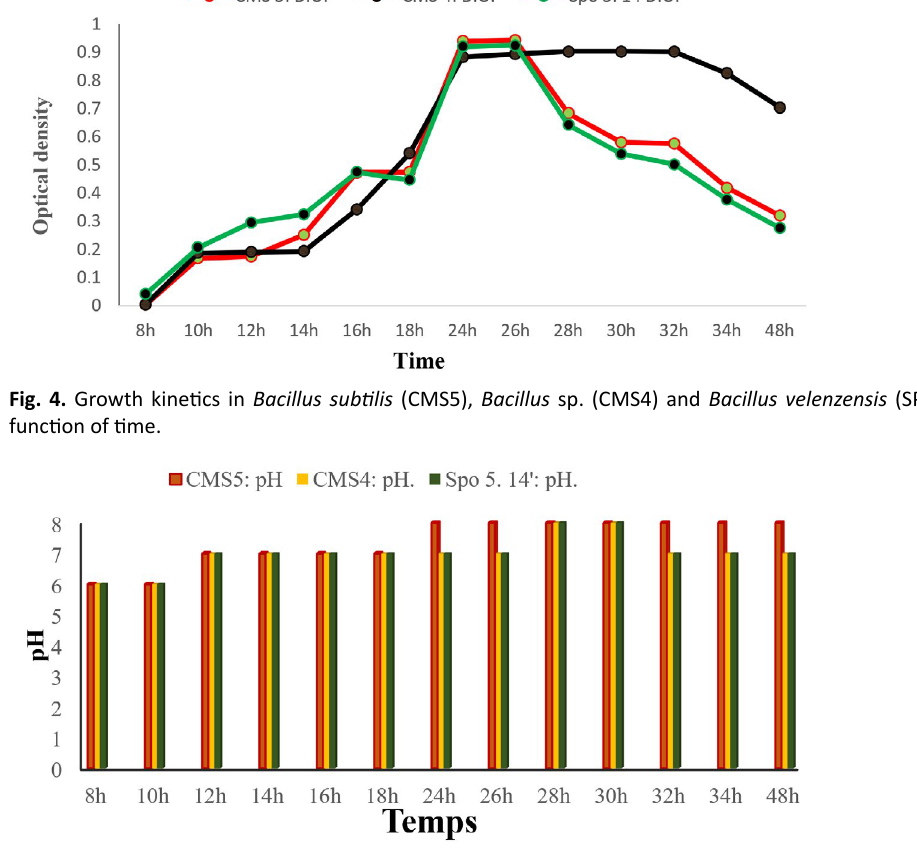
Fig. 5. Evolution of pH as a function of